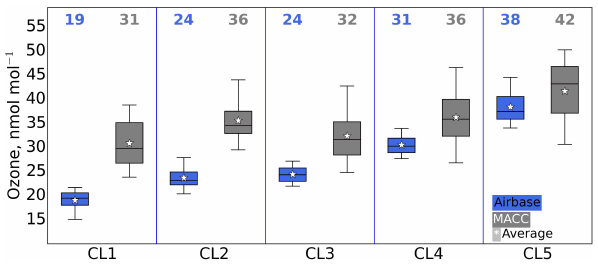
Figure 8. Percentiles (5–25–50–75–95) of ozone means in clusters; Airbase vs. MACC, second CA. Upper values indicate the mean of each